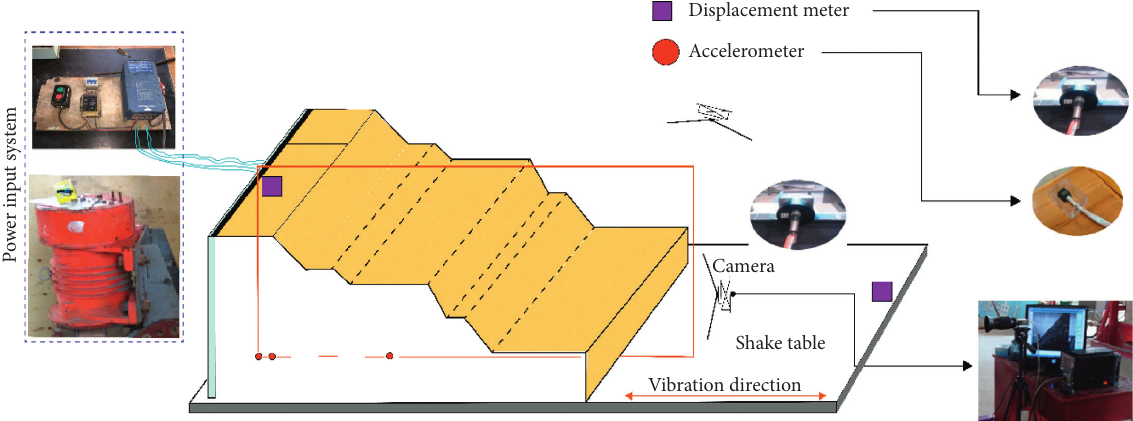
Figure 3: Test equipment and monitoring point